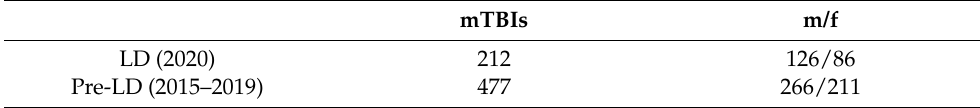
Table 5. Distribution of mTBIs during LD and the pre-LD